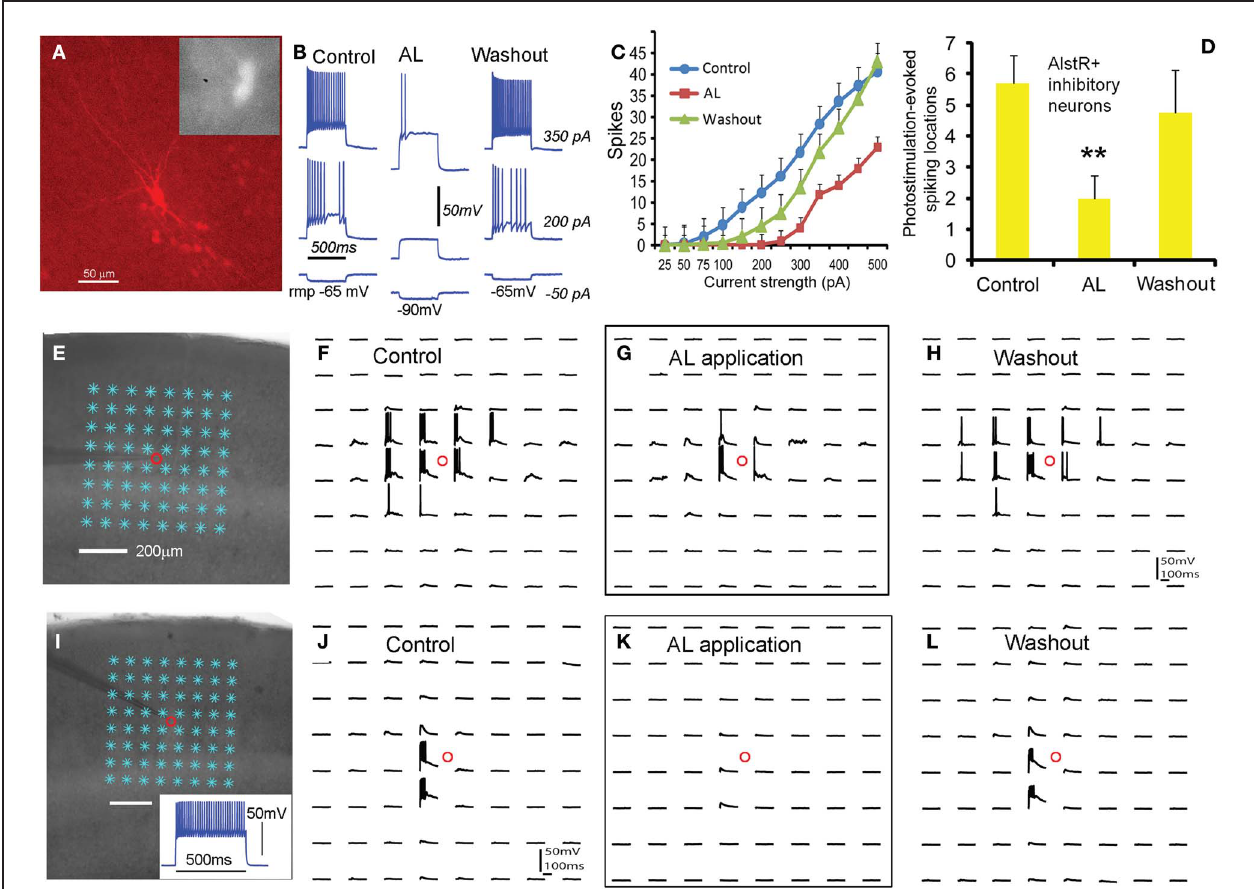
FIGURE 3 | Robust AlstR-mediated inhibition of diverse subtypes of inhibitory neurons. (A) shows one recorded inhibitory neuron expressing GFP and allatostatin receptors in the Dlx5/6-Cre: AlstR cortical slice. This cell exhibited a low-threshold-spiking phenotype with bitufted morphology. (B) and (C) shows the AL application caused a significant decrease in intrinsic neuronal excitability of the examined AlstR-expressing (AlstR + ) inhibitory neurons ( N = 12). The average hyperpolarization of inhibitory neuronal resting membrane potentials was − 11 . 4 ± 0 . 94mV. (D) shows the group data